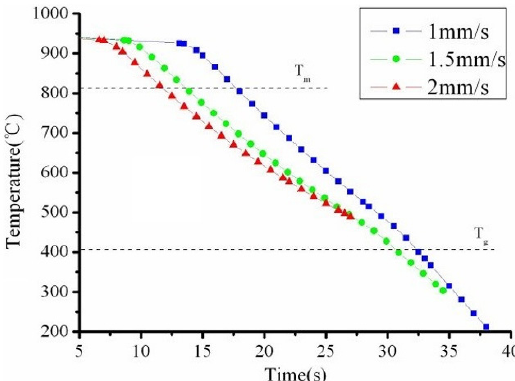
Cu Ag Al alloy rod. 48 36 8 8